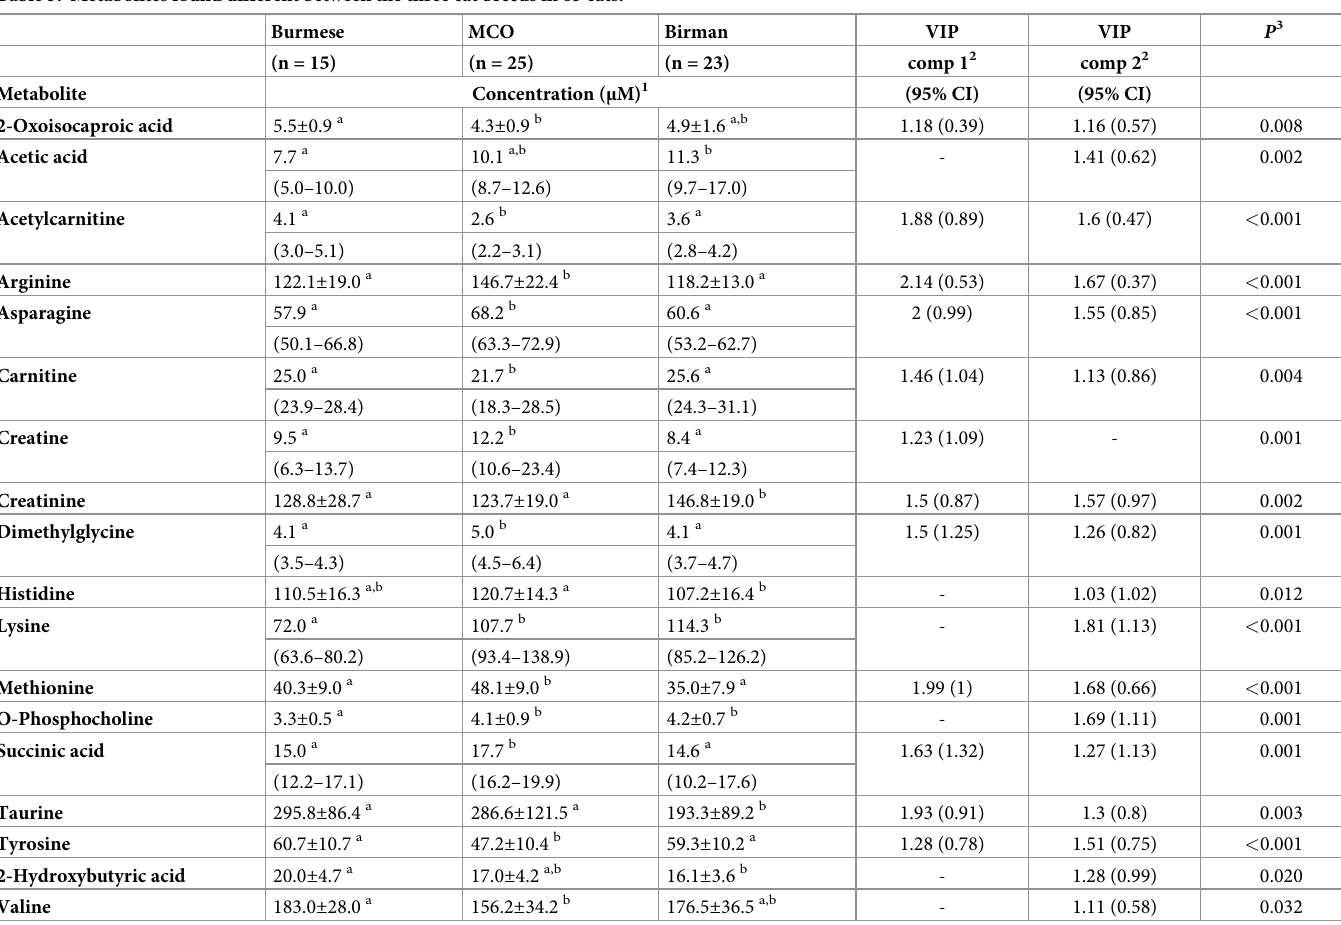
Table 3. Metabolites found different between the three cat breeds in 63